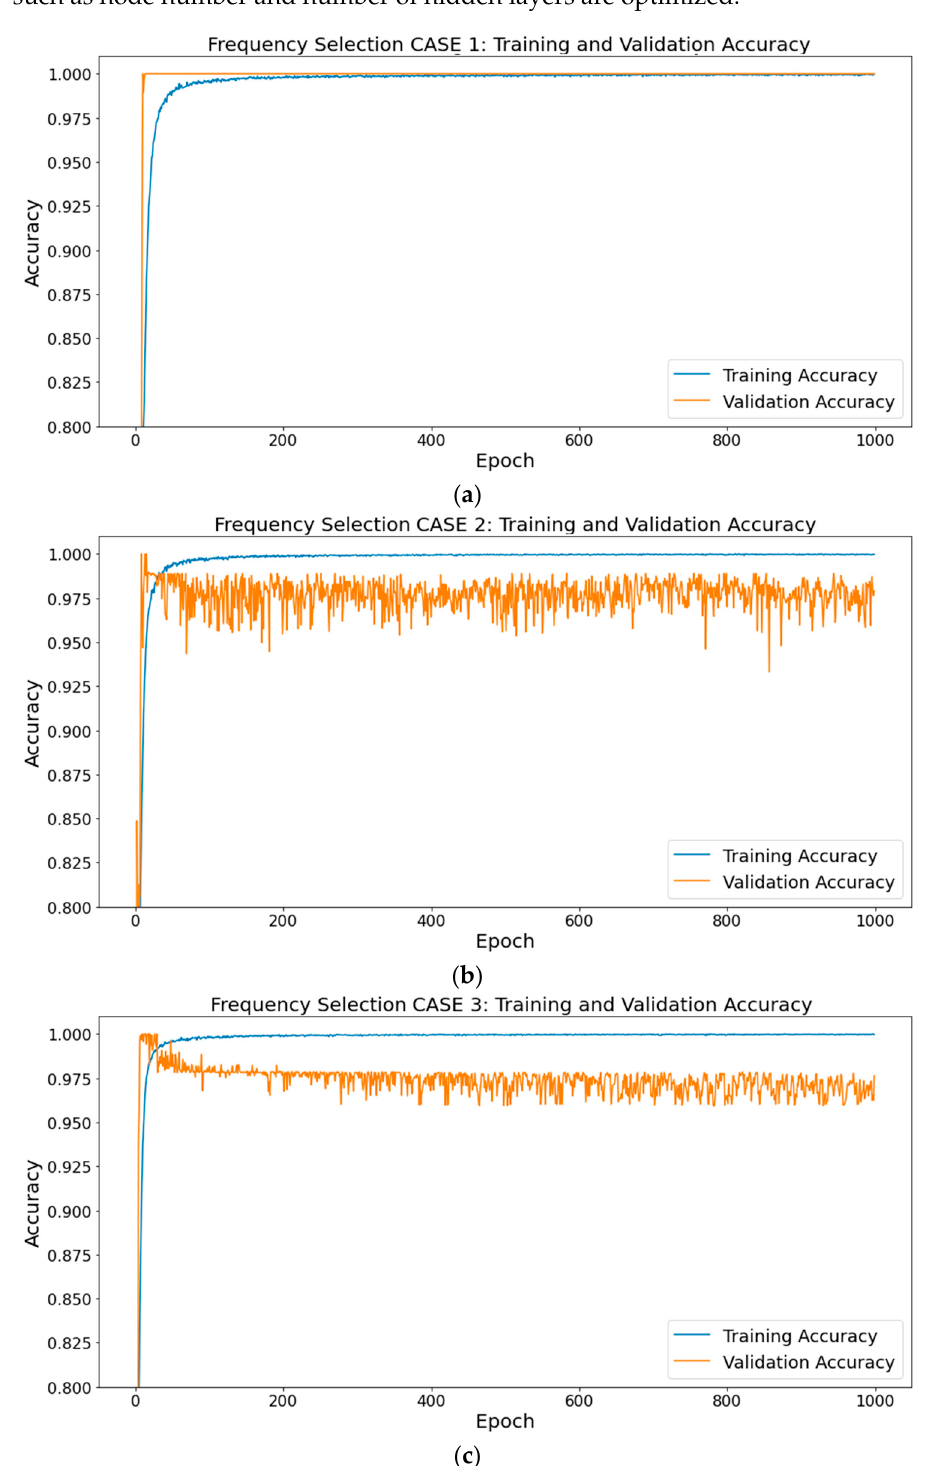
Figure 5. The accuracy of training and validation sets for different selections of frequency bands: ( a ) case 1; ( b ) case 2; and ( c ) case 3.